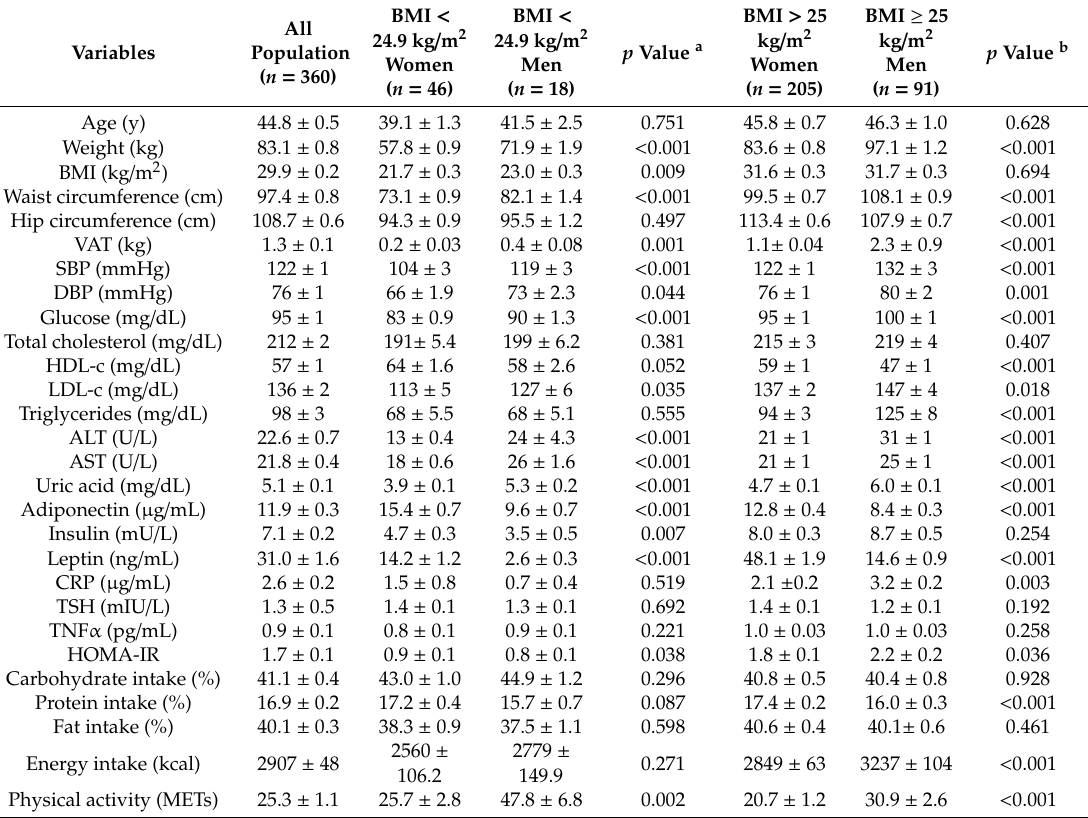
Table 1. Baseline characteristics of the entire population and separated by sex or weight status. Values correspond to the mean ±